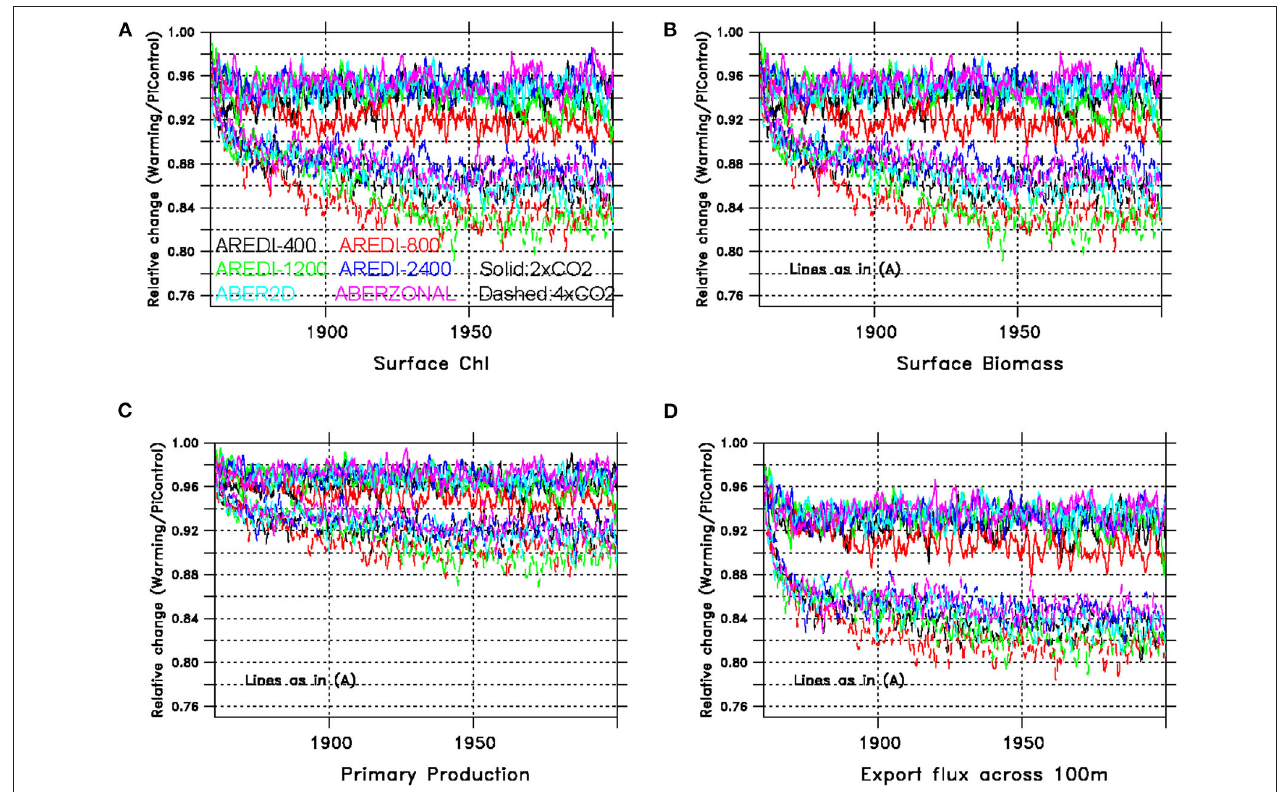
FIGURE 4 | Time series of relative changes in biological variables under doubled and quadrupled CO 2 for the different A REDI parameterizations shown as a ratio of high CO 2 /control. Upper group of lines are for doubled CO 2 , while lower group shows changes under quadrupled CO 2 . (A) Global surface chlorophyll change. (B) Global surface biomass change. (C) Global primary productivity change. (D) Global export across